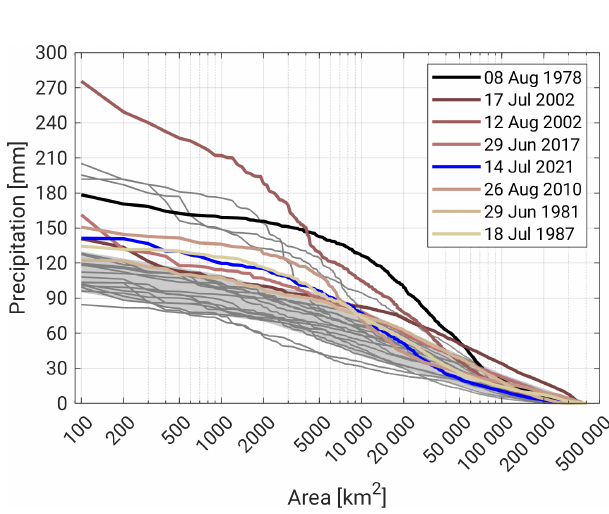
area (contiguous grid cells) for the 26 strongest precipitation events in Germany based on HYRAS-DE (1951 to 2021), applying the HPE crit criterion (see Table S2). The colored lines represent the top eight events (same as in Fig. 2), with the blue line indicating the July 2021 event. The shaded area marks the range in which more than 50% of the events are